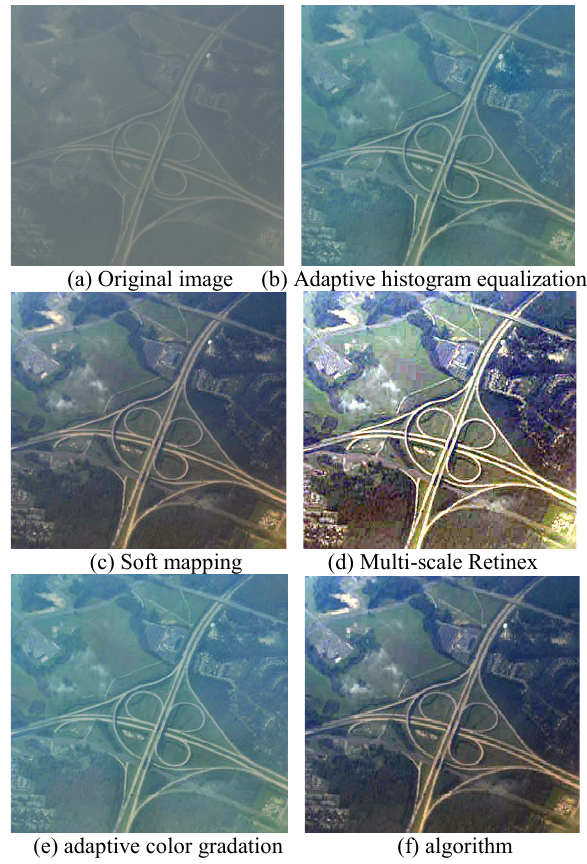
Figure 4. Different algorithm defogging effect images